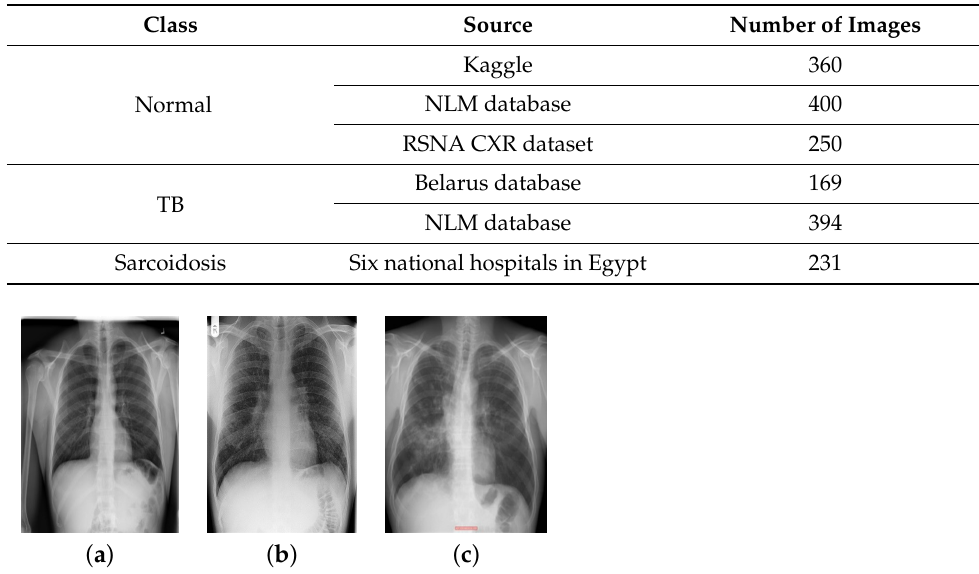
Figure 1. Different classes of chest X-ray images: ( a ) normal, ( b ) sarcoidosis-infected, ( c )